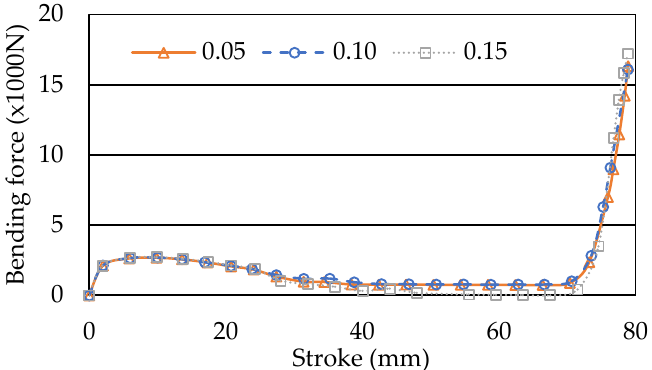
Figure 15. Bending forces calculated by FEM simulation with respect to friction coefficients. ( 𝑅 𝑝 = 3.5 mm, 𝑇 = 3 mm, 𝜃 = 30°, 𝐿 = 70 mm, l k = 60 mm, SPCC).